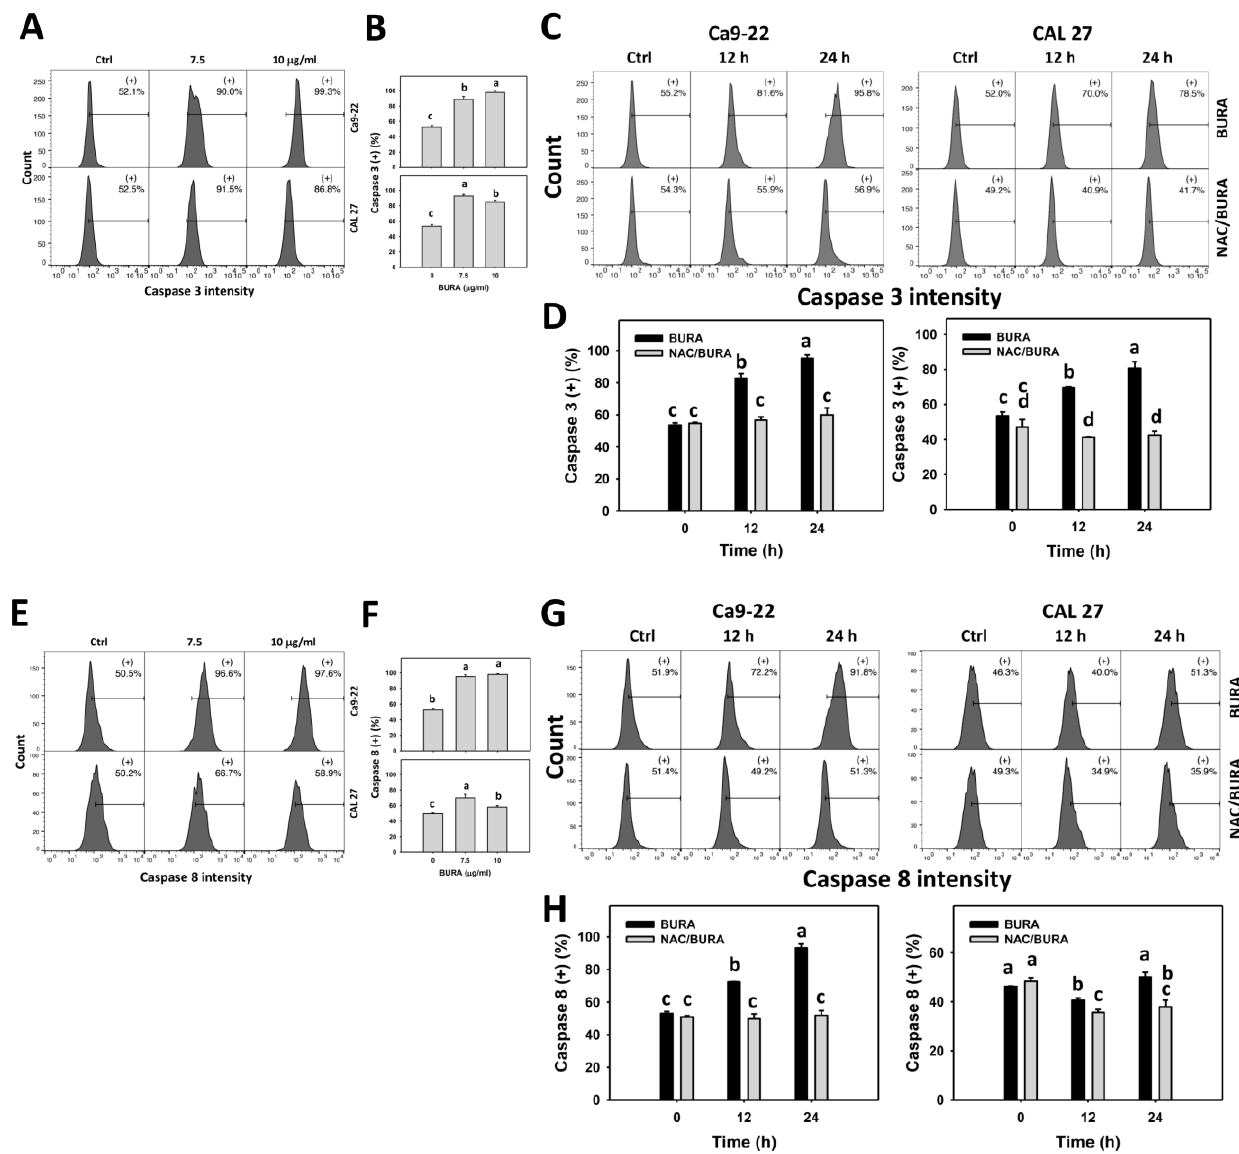
Figure 4. BURA causes pancaspase activation in oral cancer cells. ( A , B ) Pancaspase pattern and quantification. Oral cancer cells (Ca9- 22 and CAL 27) were treated with BURA (control (0.1% DMSO), 7.5 μg /mL (25.3 μM), and 10 μg /mL (33.8 μM), 24 h). (+) located within the patterns represent pancaspase (+). ( C , D ) NAC effect on pancaspase pattern and quantification. After NAC treatment (10 mM, 1 h), cells were treated with BURA (10 μg /mL) for 0 (control), 12 and 24 h. Data, mean ± SD ( n = 3). Data top-labeled with non-overlapping lower-case letters differ significantly according to multi-comparisons ( p < 0.05).